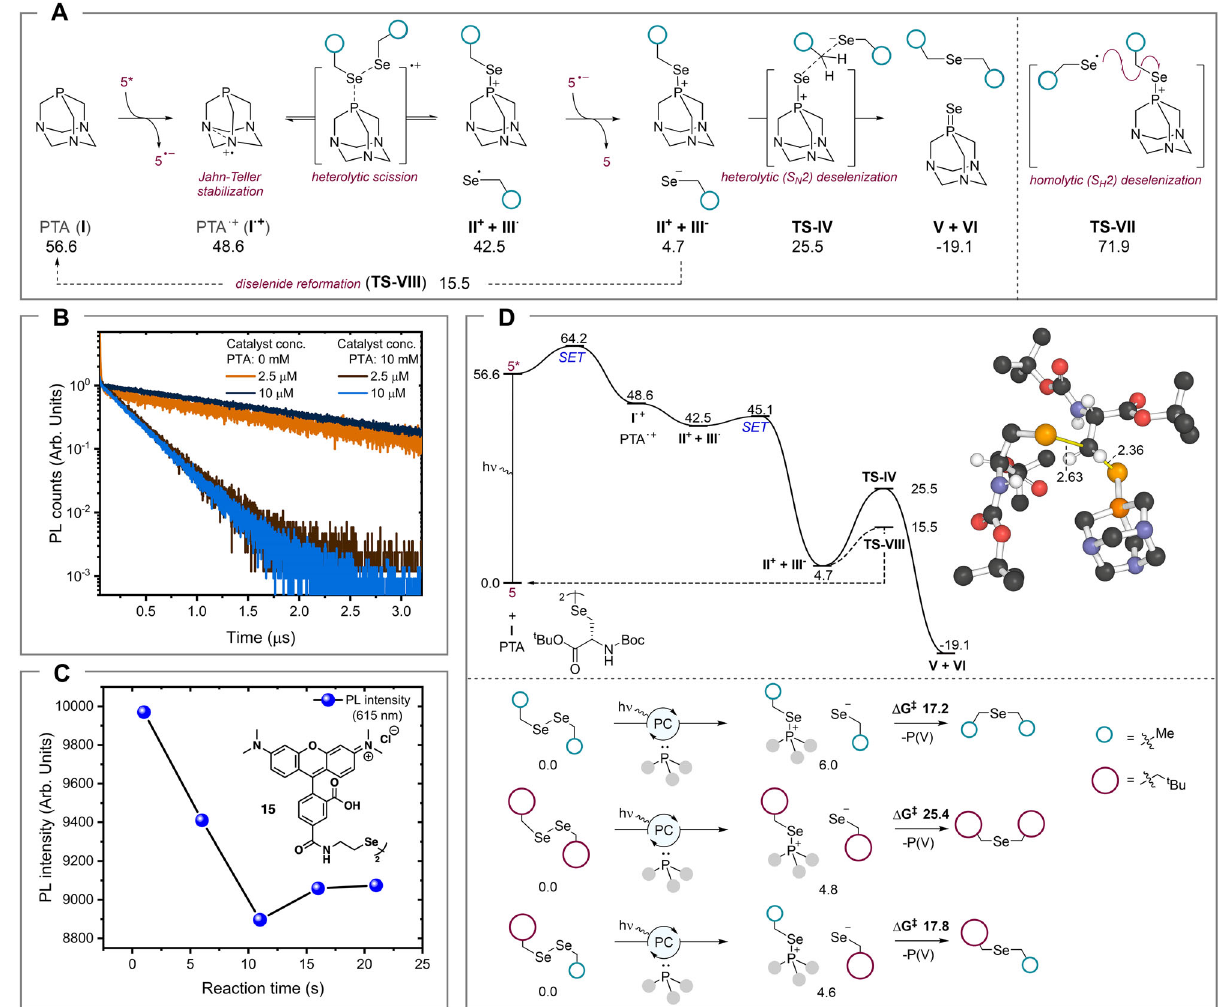
Fig. 2 | Mechanistic insights into the PDC reaction. A Proposed mechanism for the PDC reaction that converts diselenides to selenoethers. B Normalized photo- luminescence (PL) counts of photocatalyst [Ir(dF(CF 3 )ppy) 2 (dtbpy)] ( 5 ) ( c =2.5 μ M and 10 μ M) in argon-sparged 1:1v/v H 2 O:MeCN over a period of 3 μ s monitored at 470nm(excitationwavelength415nm)withorwithoutPTA( 4 )(0mMand10mM). C Changes in the PL intensity of 5-carboxytetramethylrhodamine (TAMRA)-deri- vatized selenocystamine ( 15 ) in the presence of [Ir(dF(CF 3 )ppy) 2 (dtbpy)] ( 5 ) and